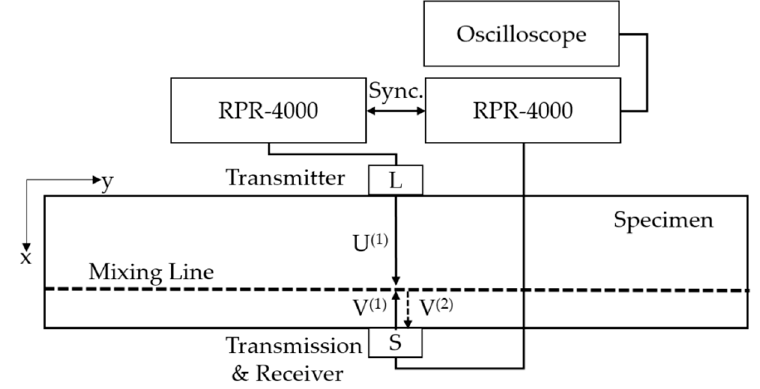
Figure 7. Schematic of wave mixing experimental setup.